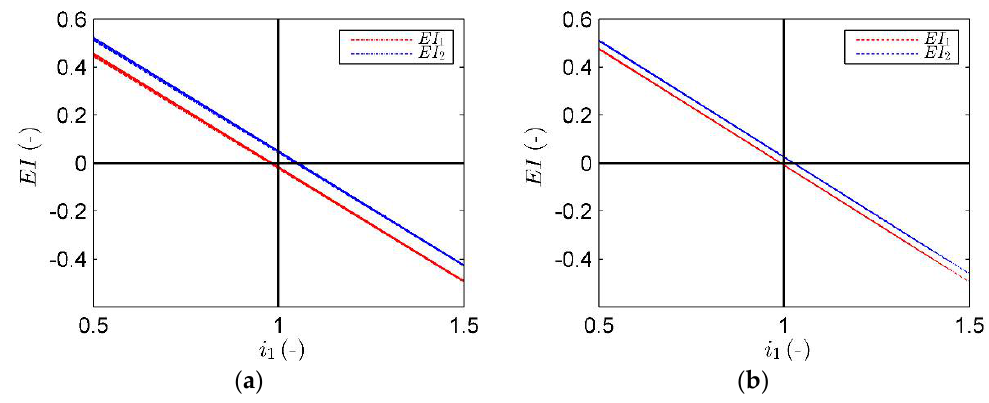
Figure 12. Trend of efficiency indices for ∆ H ind = 50 m ( a ) and ∆ H ind = 100 m ( b ), with i 2 equal to 25%, 50%, and 75%, respectively. Table 2. Main figures of the indirect and direct pumping scenarios.